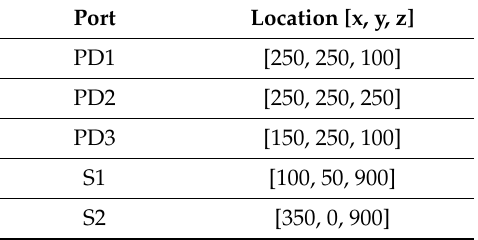
Table 2. Location of the considered UHF probes and PD sources inside the transformer tank.